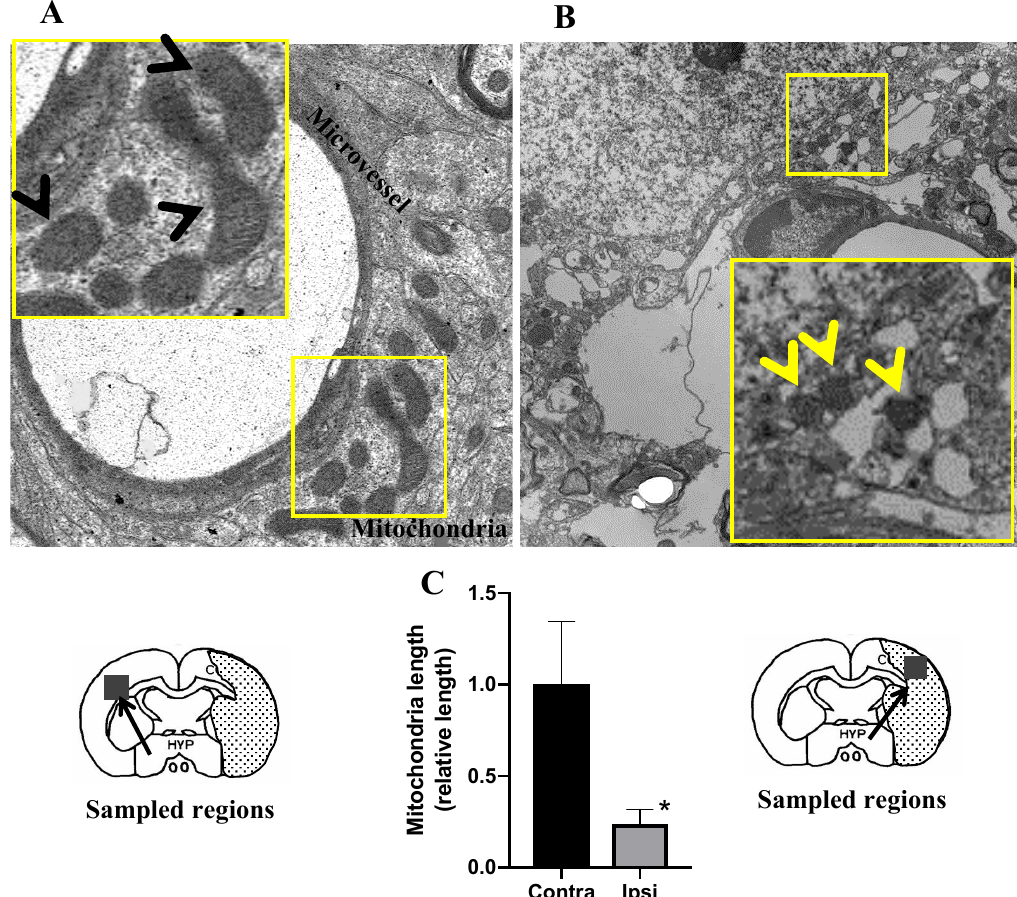
Figure 5. Brain microvessel with surrounding mitochondria visualized using TEM at 12 h after reperfusion. ( A ) A representative TEM image from the contralateral hemisphere. A higher magnification of the boxed area is shown at the upper left corner. Black arrow heads indicate normal mitochondria. ( B ) A representative TEM image from the ipsilateral hemisphere. A higher magnification of the boxed area is shown at the lower right corner. Yellow arrow heads indicate small and fragmented mitochondria. ( C ) The length of mitochondria in the contralateral and ipsilateral hemisphere were determined. The results were expressed as relative values of contralateral side. ( n = 6, * p < 0.05)